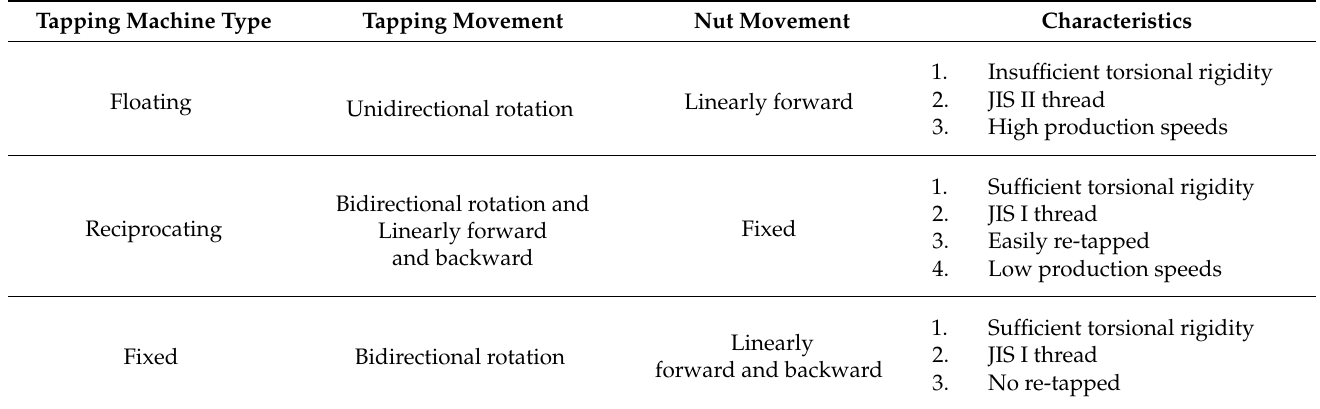
Table 1. The differences among floating, reciprocating, and fixed tapping